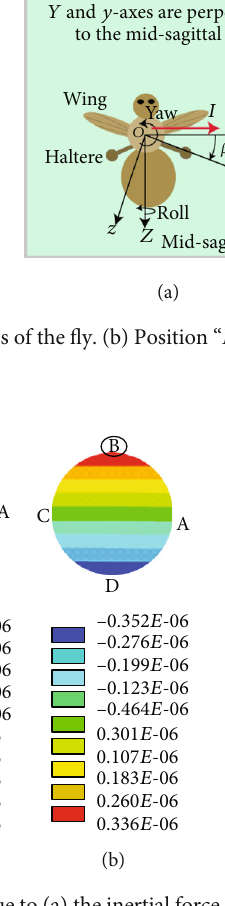
Figure 8: Strain distribution due to (a) the inertial force and (b) the combined e ff ect of the inertial and Coriolis forces due to the 10rad/sec pitch rotations.